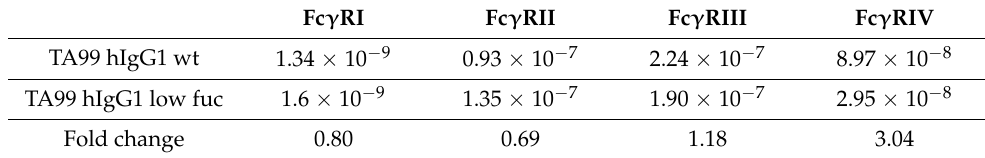
Table 1. Dissociation constant (Kd) of humanized IgG1-TA99 mAbs and mouse Fc γ